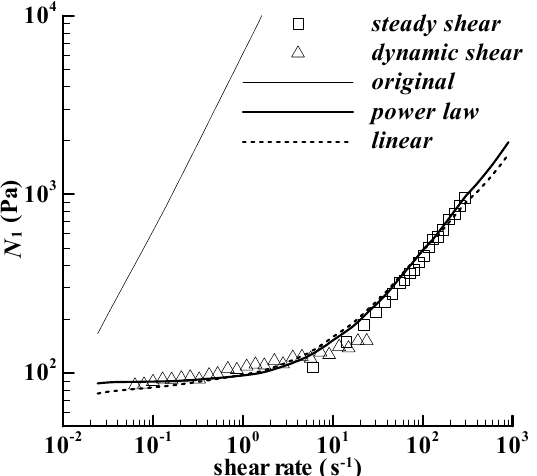
Figure 3. First normal stress difference of the cross-linked waxy corn starch dispersion at 20 °C, which is mixed with 300 g/kg sucrose and heated to 85 °C in the Rotavapor. Symbols are the experiments in Figure 9a of Acquarone and Rao [18], and lines are calculations. The ‘original’, ‘power law’, and ‘linear’ are the calculations using Equations (6)–(8),